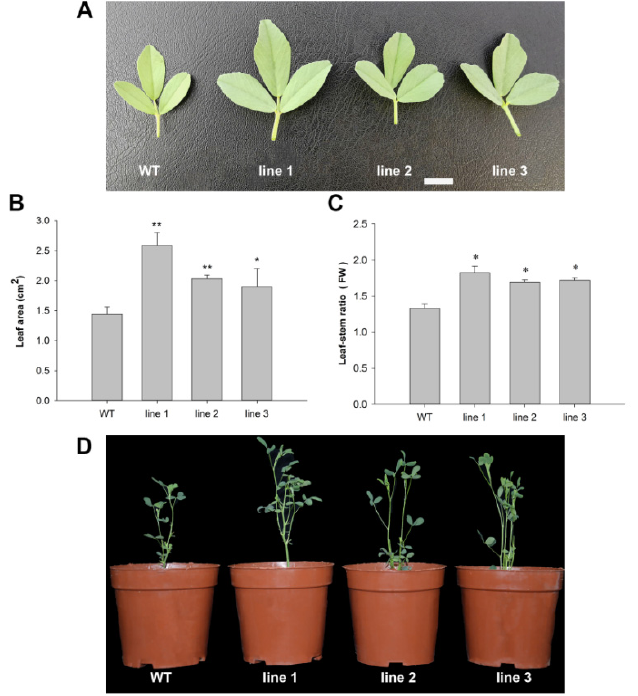
Figure 5. Phenotypic analysis of transgenic alfalfa. ( A ) Leaf size of the third leaf from the top of six-week-old alfalfa. ( B ) Leaf area index of WT and transgenic alfalfa. ( C ) Leaf-stem ratio of WT and transgenic alfalfa. ( D ) Branches of six-week-old WT and transgenic alfalfa. Data were expressed as mean ± SE (n ≥ 30). WT: wild-type alfalfa; line 1, 2, 3: transgenic alfalfa. * and ** indicate statistically significant differences at p < 0.05 and p < 0.01, respectively.